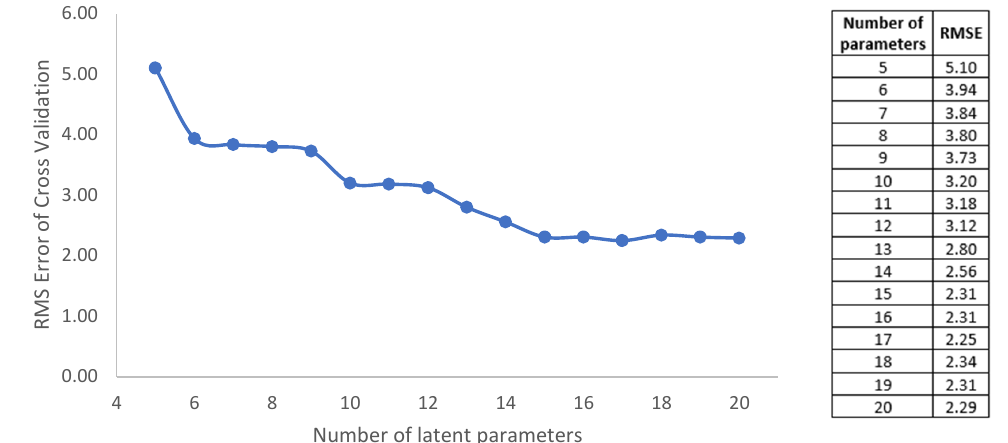
Figure 8. PIP values for the chosen model. Values lower than 0.03 are excluded from the model, so the parameters 𝜃 (cid:2876) ,𝜃 (cid:2877) ,𝜃 (cid:2869)(cid:2875) ,𝜃 (cid:2869)(cid:2868) 𝑎𝑛𝑑 𝜃 (cid:2869)(cid:2877) are excluded from the model.